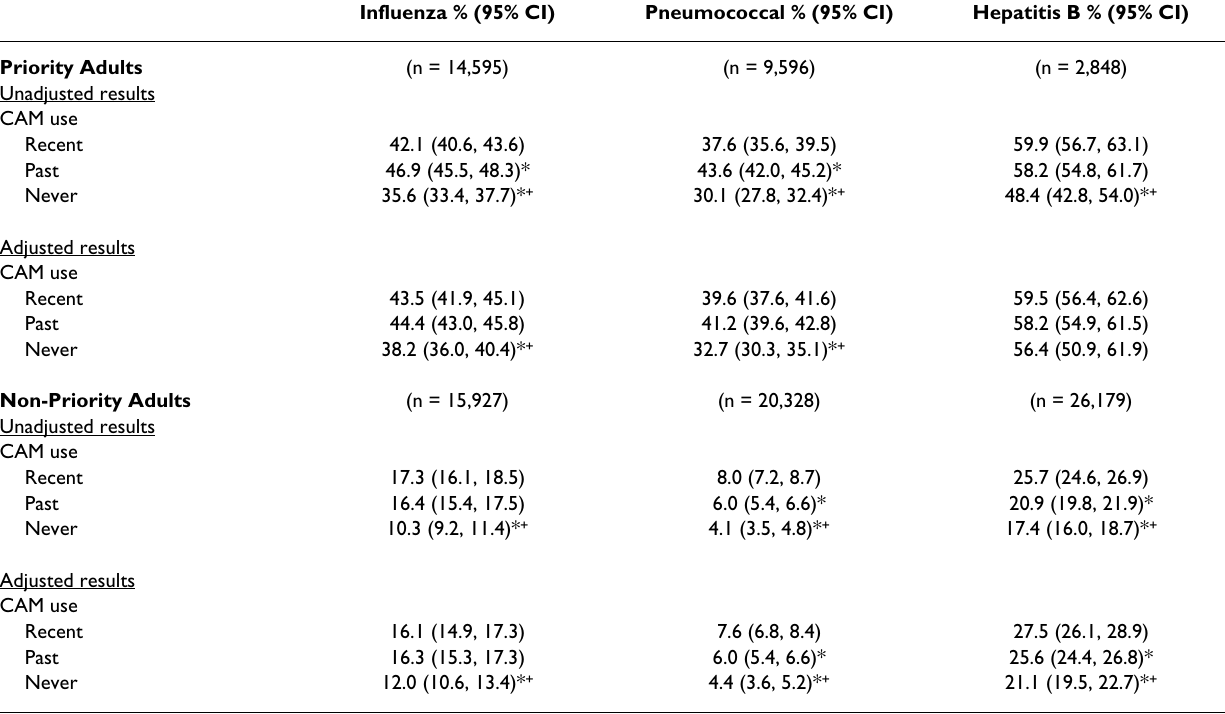
Table 3: Unadjusted and adjusted a vaccination coverage levels among priority and non-priority adults by CAM use, 2002 National Health Interview